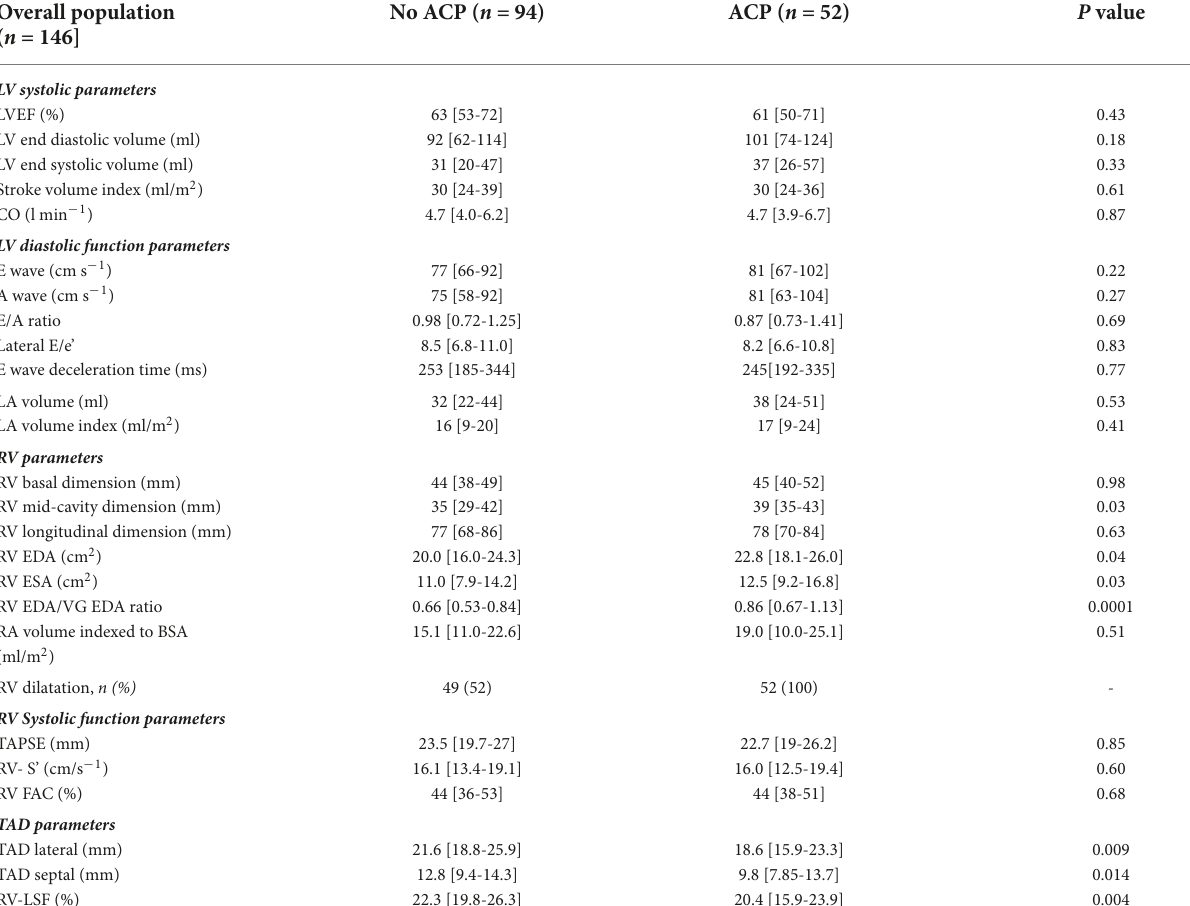
TABLE 2 Echocardiographic